Question: In a single sentence, describe what this figure presents.
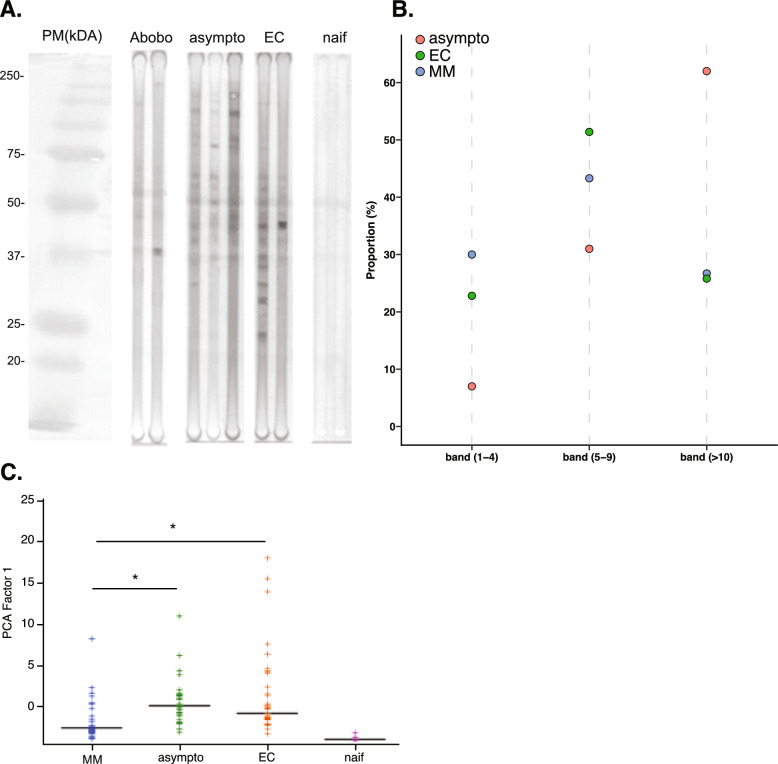
Answer: Profiles of IgG reactivities to brain antigens in the different participant groups from Abobo. A Example immunoblot profiles of sera reactive to brain antigens from EC, AS, and MM participants. Each strip contains approximately 10 µg of human brain extract; MW, molecular-weight marker; malaria-naïve, European control sera from individuals with no history of malaria exposure. B Percentage of individuals in each clinical group distributed according to the number of reactive bands (1–4, 5–9, and > 10). C PCA factor 1 score from adjusted IgG reactivity profiles. Asterisks indicate statistically significant differences between groups (* p < 0.05; ** p < 0.01; *** p < 0.001)